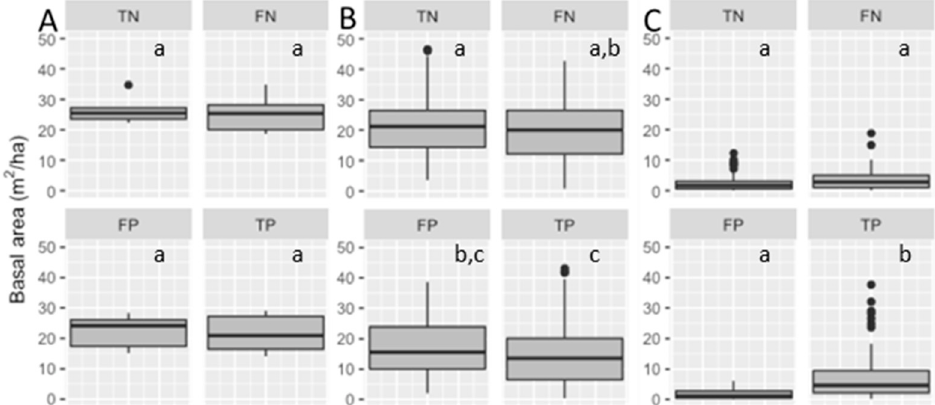
Figure 2. Living overstory basal area ( A ), living black spruce overstory basal area ( B ), and dead black spruce overstory basal area ( C ) within each of the four predictive groups (true negative (TN), false negative (FN), false positive (FP), and true positive (TP)). Panels with the same letter are not significantly different by Tukey’s HSD test at a 0.05 level of significance for each predictive group.